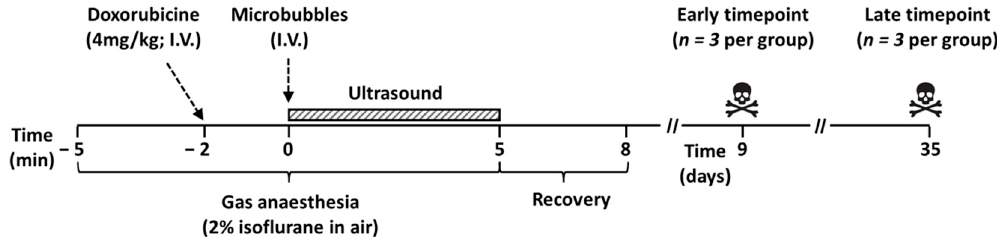
Figure 1. Timeline of the experimental setup. Mice were anesthetised five minutes prior to the ultrasound treatment. Doxorubicin was injected two minutes prior to the ultrasound treatment, and the microbubbles were injected immediately before ultrasound application, which lasted for five minutes. Mice were kept in a UV-heated chamber for recovery for approximately three minutes. Mice were sacrificed after 9 or 35 days.